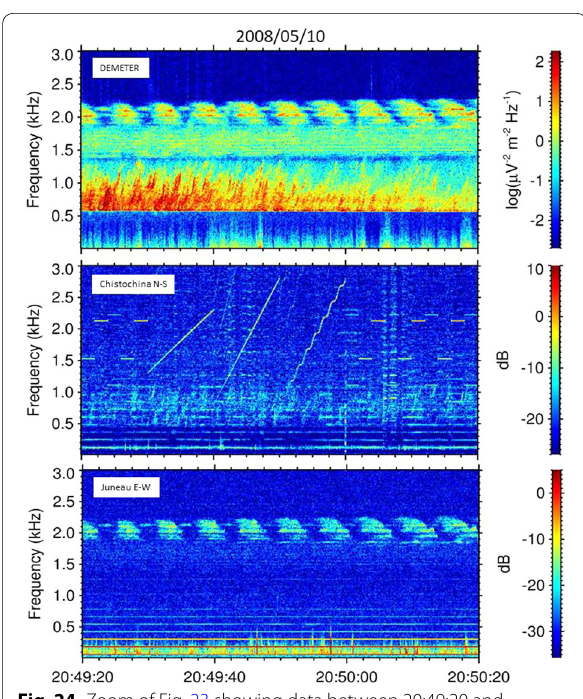
first two panels. The third panel represents the ellipticity E B (ratio of the axes of the polarization ellipse) obtained